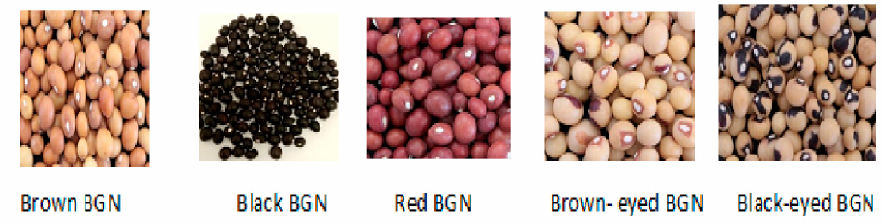
Scheme 1. Picture of different varieties of Bambara groundnut (BGN) studied .